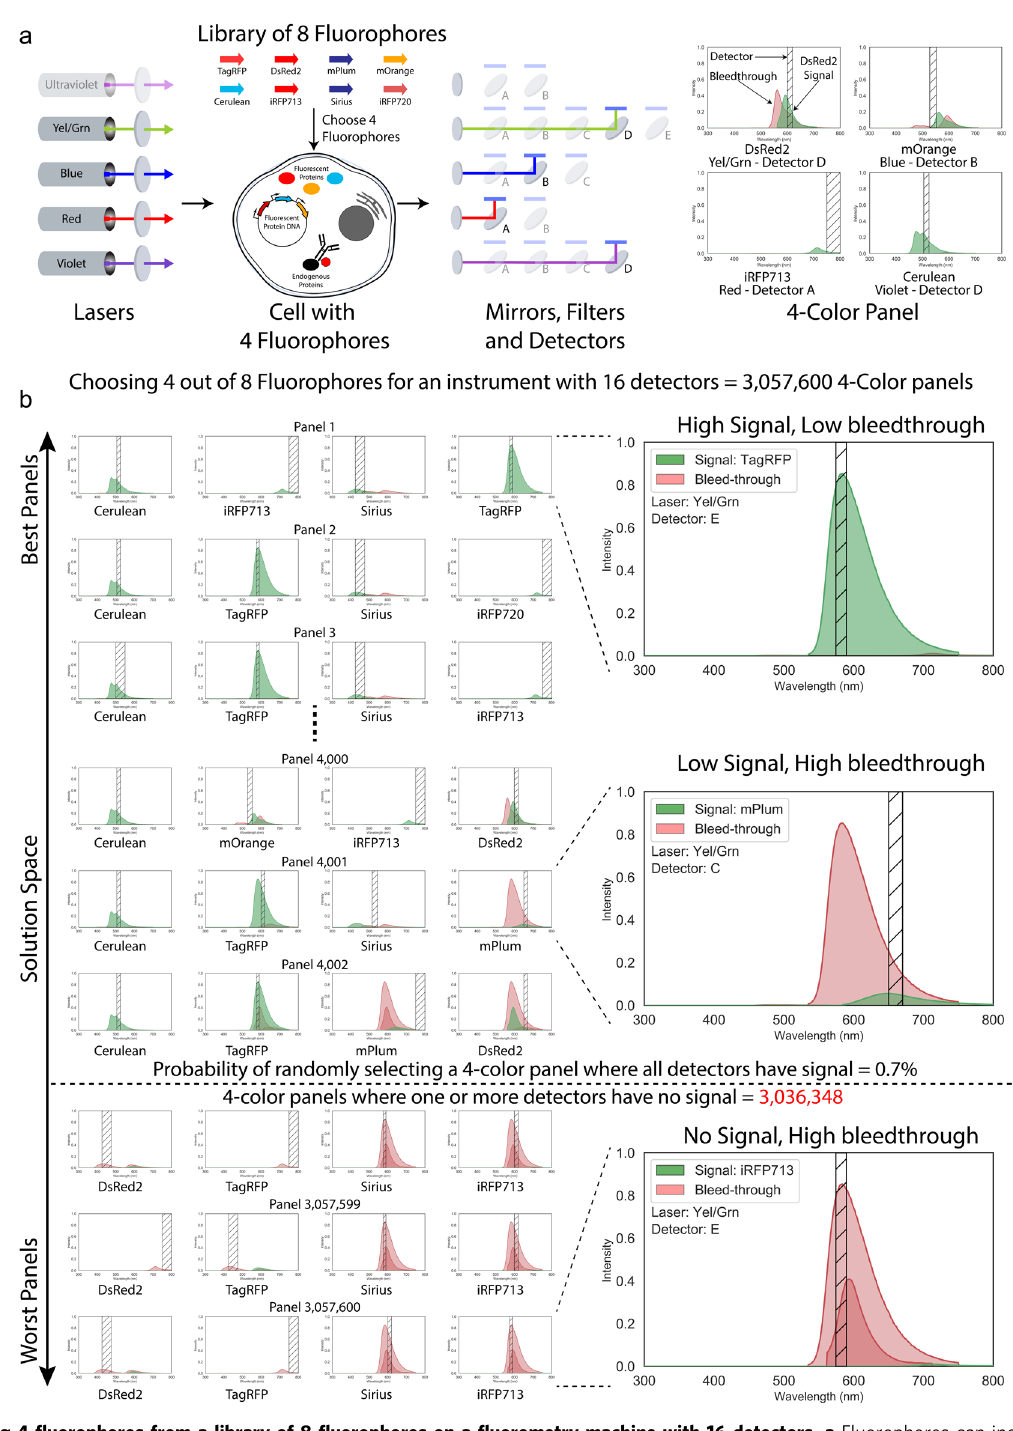
COMMUNICATIONS BIOLOGY| (2021) 4:118 |https://doi.org/10.1038/s42003-020-01599-5|www.nature.com/commsbio